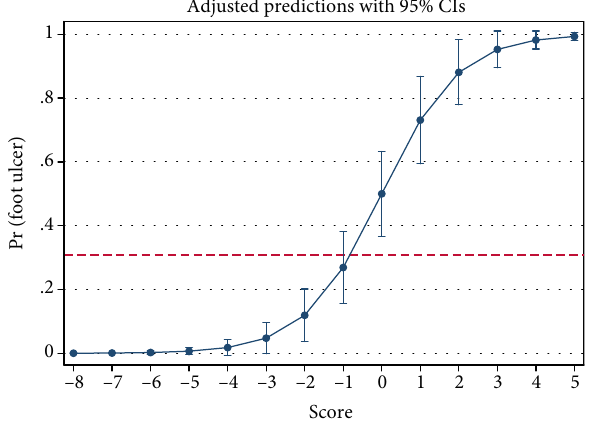
Figure 4: Marginal analysis shows the probability of diabetic foot ulcer at each score. The reference line shows the prevalence of diabetic foot ulcers in the studied samples 30.83% (pretest